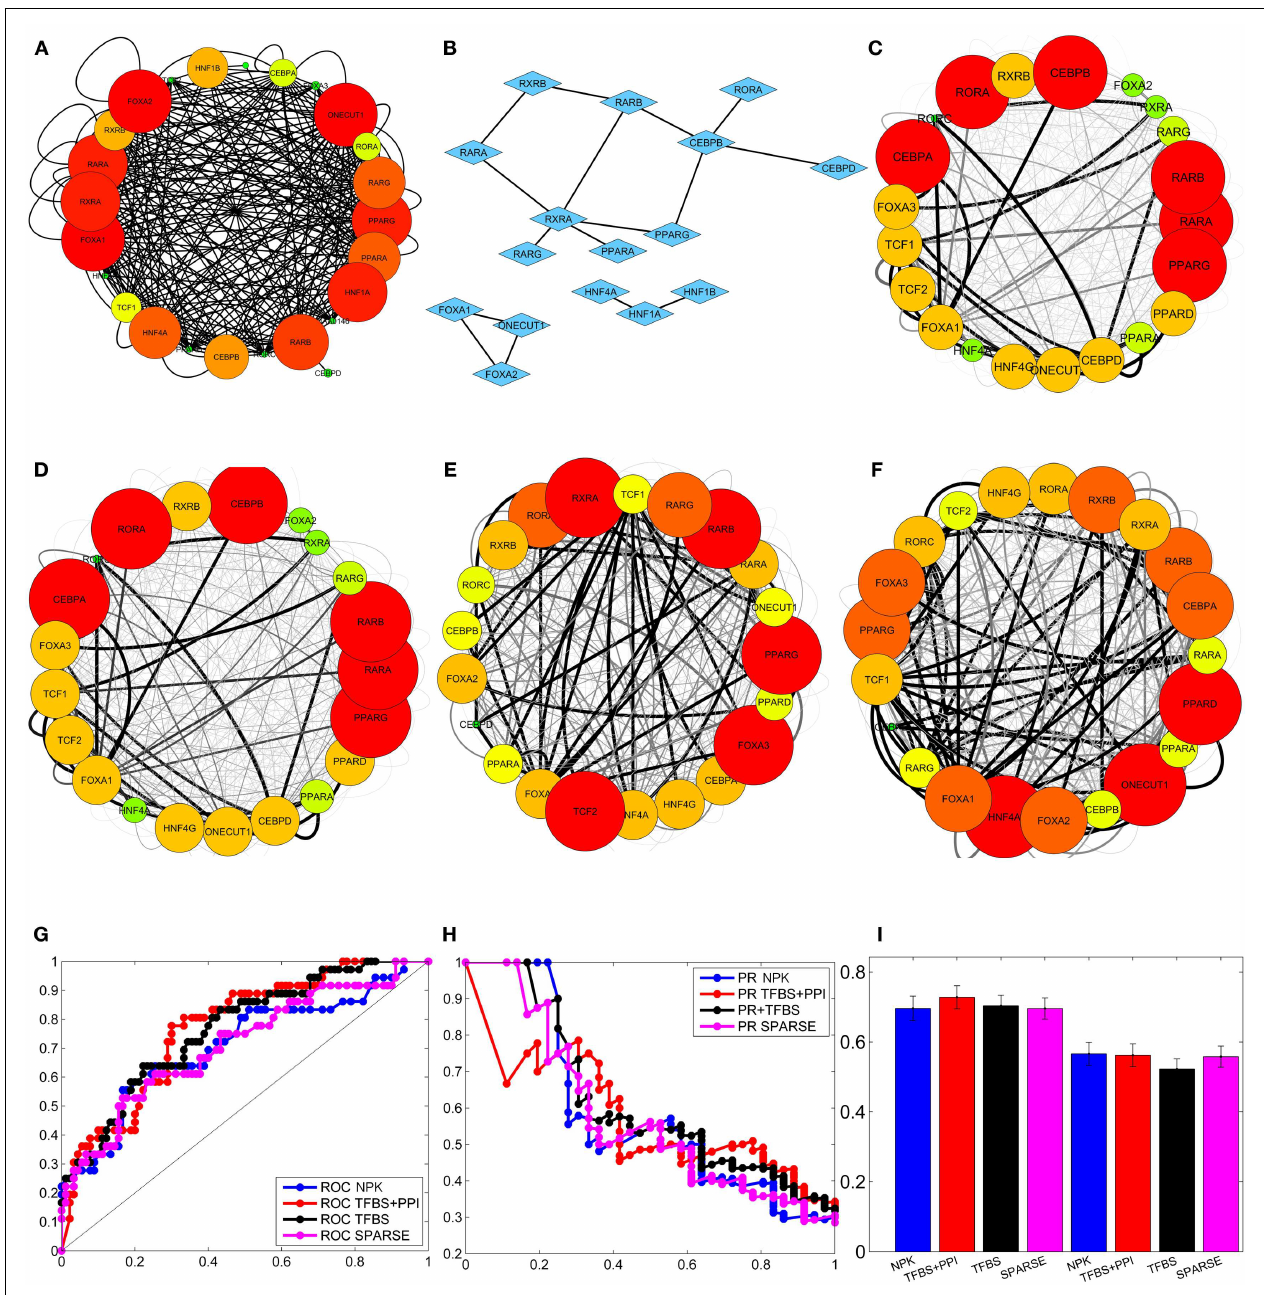
information.The interactions that occur with high and low posterior probabilities are represented by darker/thicker and lighter/thinner edges, respectively, in (C) , (D) , (E) , and (F) . (G) Average ROC curves of the inferred networks. (H) Average PR curves of the inferred networks. (I) mean and standard deviation of the area under the ROC and PR curves of the inferred